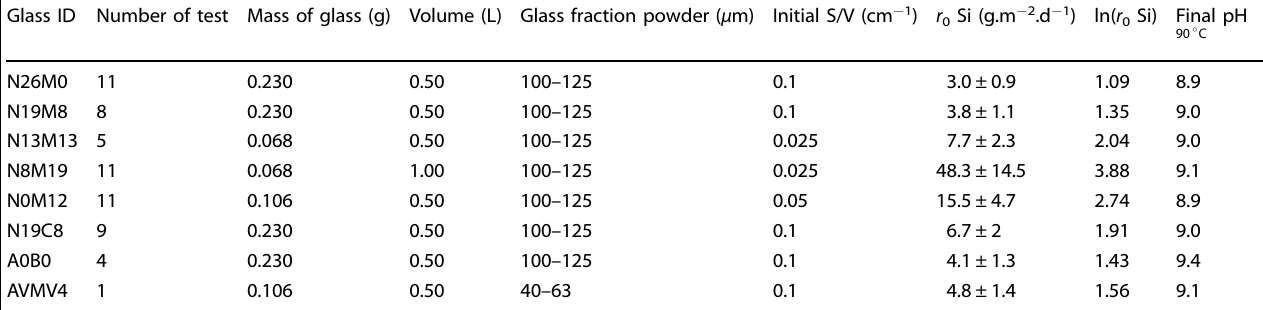
Table 2. Parameters of initial dissolution rate r 0 experiments, alongside r 0 values calculated by linear regression based on NL Si . pH values are given with a ± 0.1